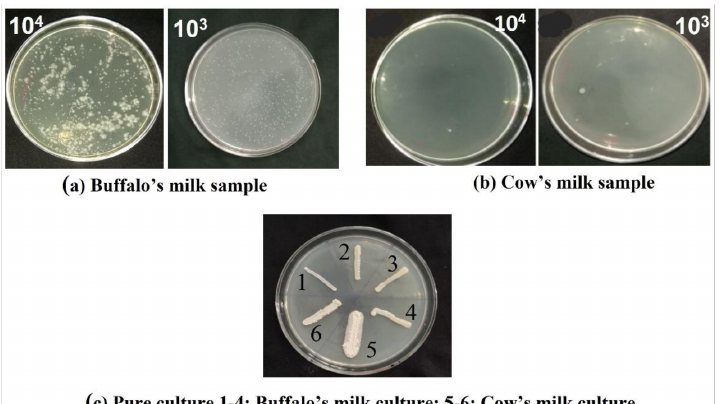
Figure 1. Growth of bacterial colonies cultured from 100 µ L of sample of ( a ) Buffalo milk and ( b ) Cow milk from the diluted milk samples (1:10 3 and 1:10 4 ) spread over the MRS agar plates and incubated for 48 h was screened and isolated Pure culture ( c ) of bacterial colonies were recorded.